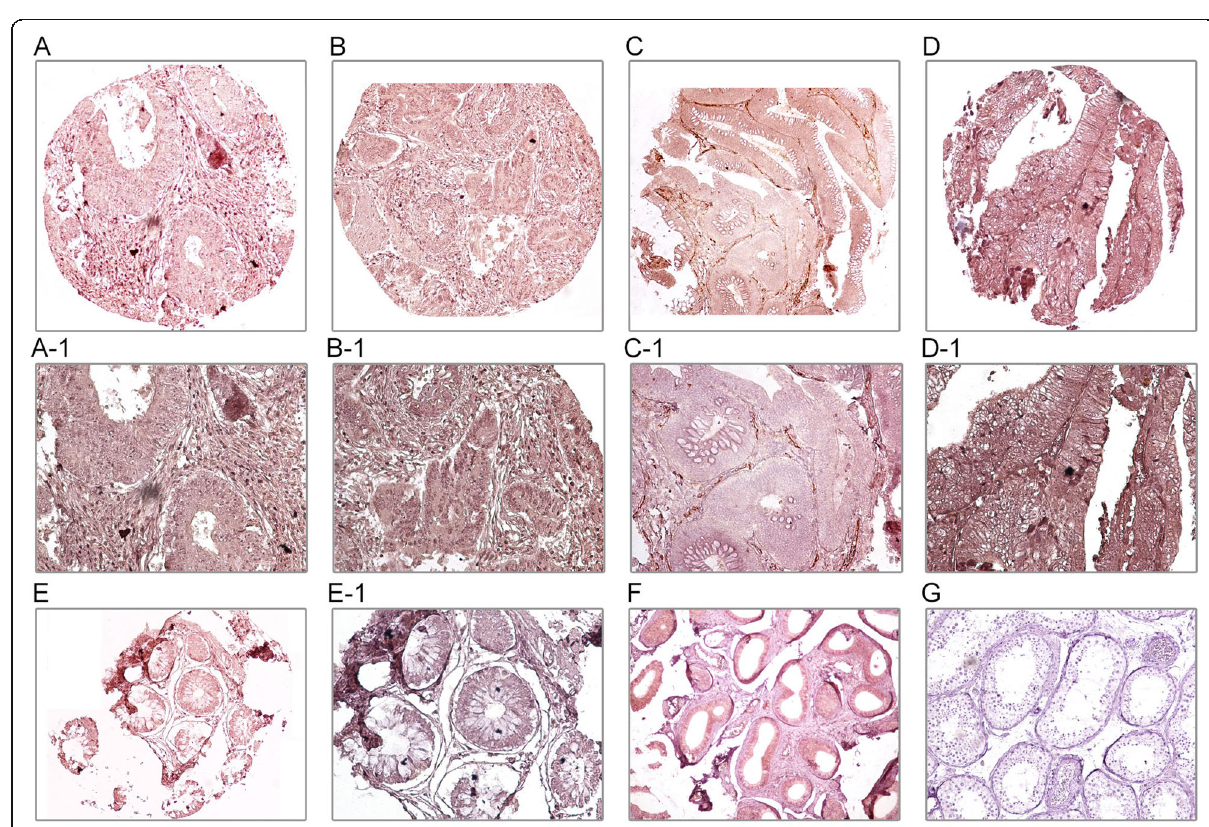
Fig. 1 Immunohistochimecal staining of TWIST1 in colorectal cancer (CRC) tissues, adjacent normal tissues, and normal testis controls. Nuclear TWIST1 expression in tumor cells: low expression a-a1 and high expression b-b1 . Cytoplasmic TWIST1 expression in tumor cells: low expression c- c1 and high expression d-d1 . Adjacent normal tissues e-e1 . Normal testis tissues as controls: positive f and negative